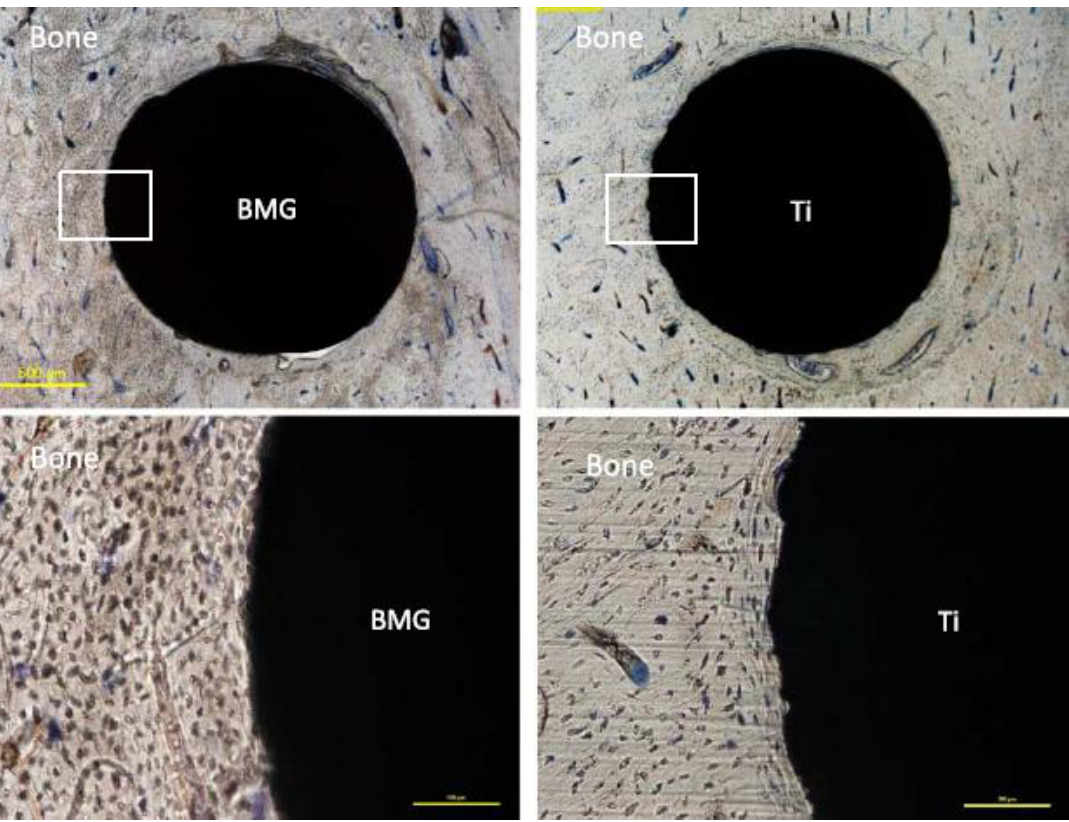
Figure 17. Histological views of Ti-based BMG implant and Ti implant. Both samples are well covered by surrounding bone tissue. Objective magnification of upper images is ×4, and that for lower images is ×20. Reproduced with permission from [230]. Copyright 2015, IOS press.